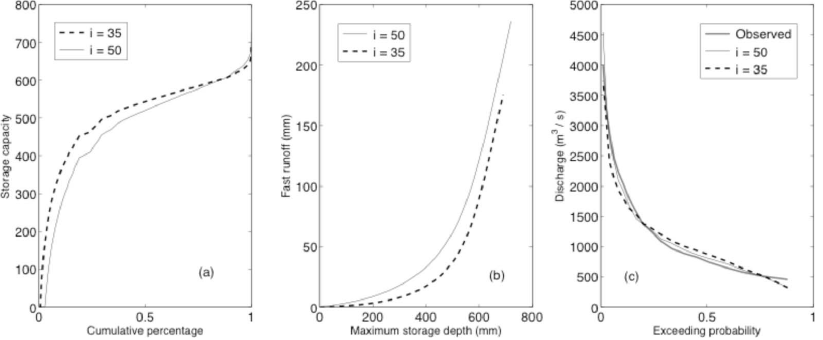
Fig. 10. (a) Basin average cumulative distributions of storage capacity for Dongjiang river basin with i =35 and i =50. (b) Basin average relationship between the maximum storage depth and fast runoff in the Dongjiang river basin derived from (a) . (c) Flow duration curve of observed discharge and TRG simulated discharge.